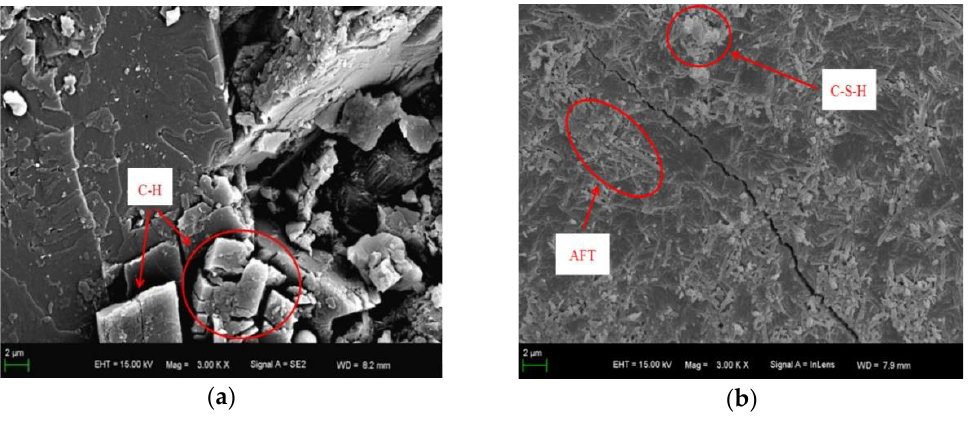
Figure 21. Micromorphology of matrix. ( a ) SF0 and ( b ) SF10.